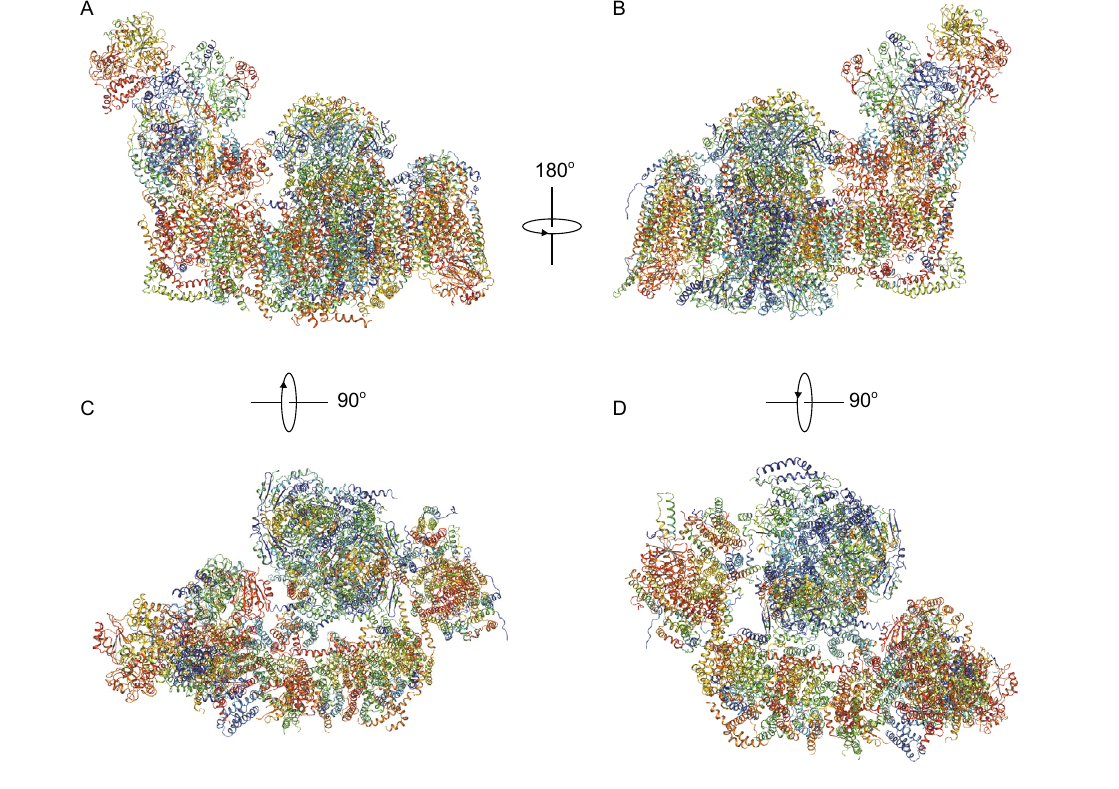
Figure 2. Overall structure of respirasome. The structure of respirasome from porcine heart at a resolution of 5.4 Å. (A) front view; (B) back view; (C) top view; (D) bottom view. The relations between the views are indicated by the